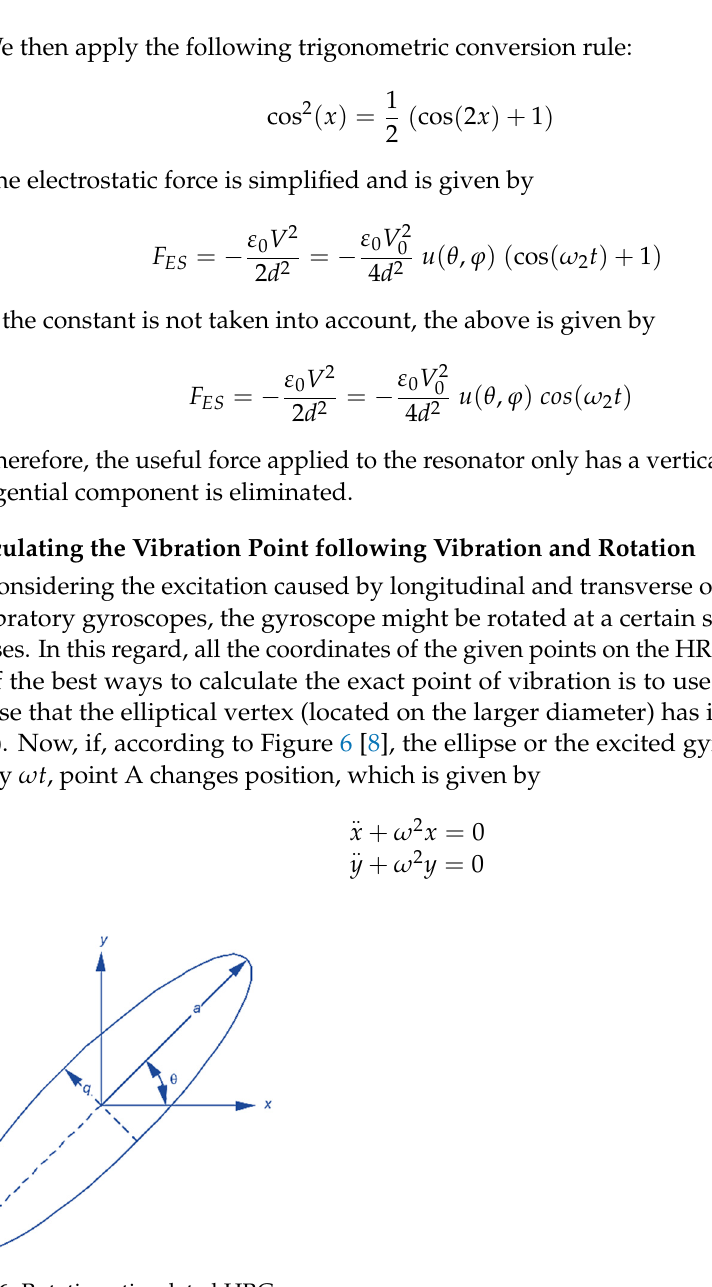
Figure 6. Rotating stimulated HRG gyroscope.